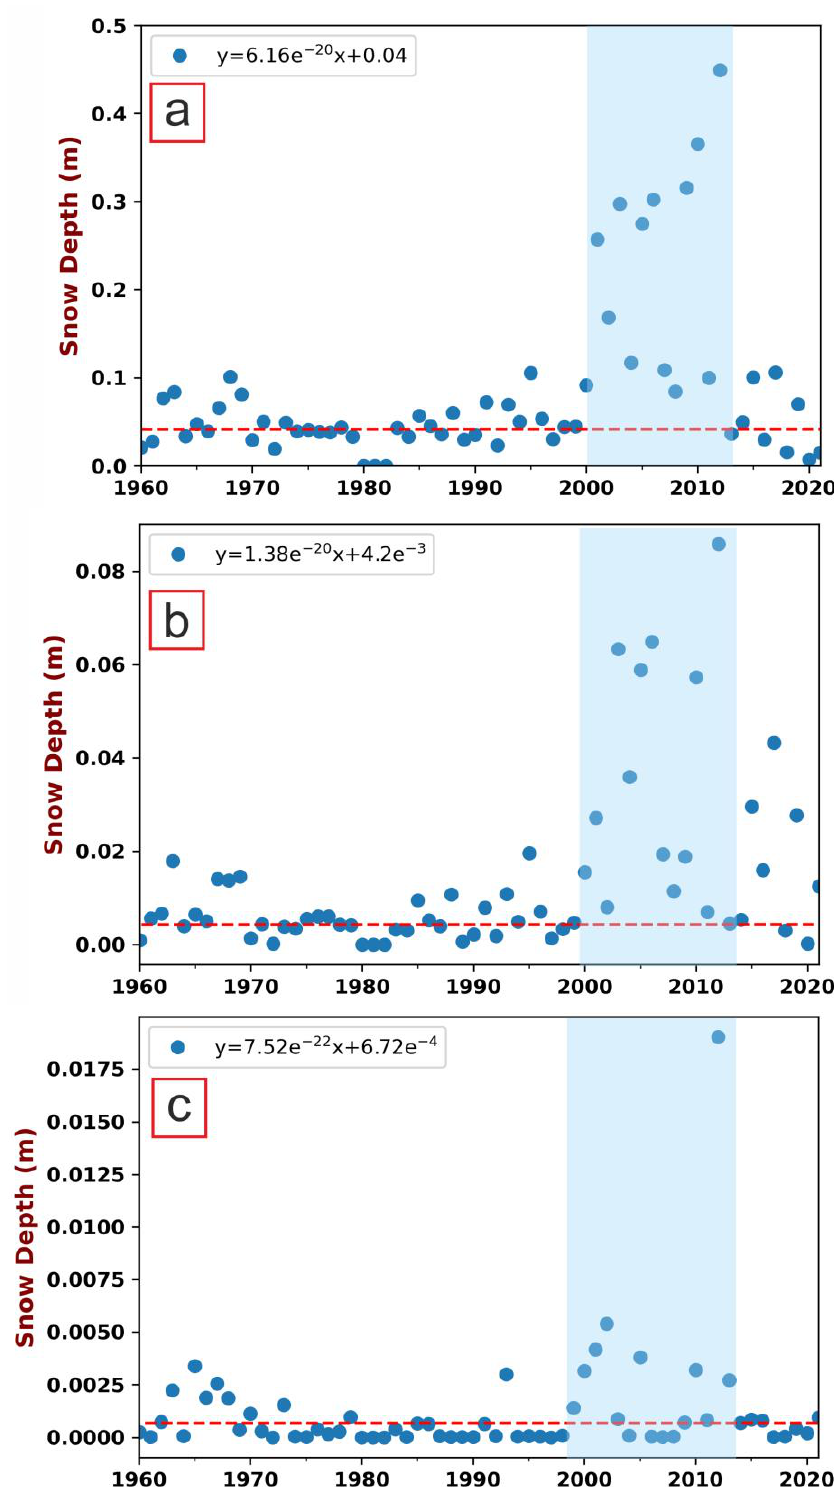
Figure 6. Monthly averaged accumulative snow depth (m) time series: ( a ) inAnthemountas basin, ( b ) in Mouriki basin, and ( c ) in Upper Volturno-Calore basin, during the period 1960–2021 derived from the GLDAS dataset. Highlighted is the period with the increased values.